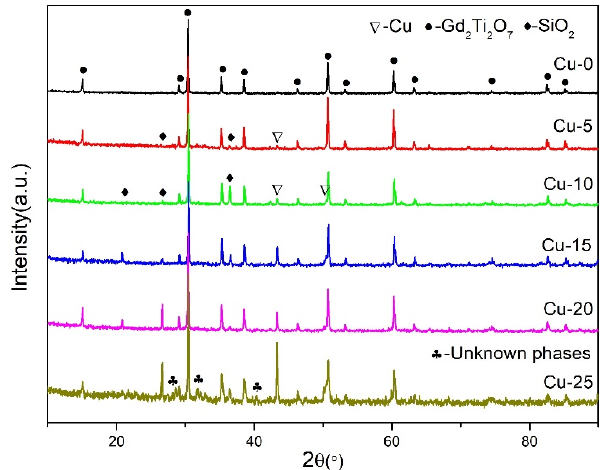
Figure 3. X-ray diffraction (XRD) patterns of all SHS-ed samples.